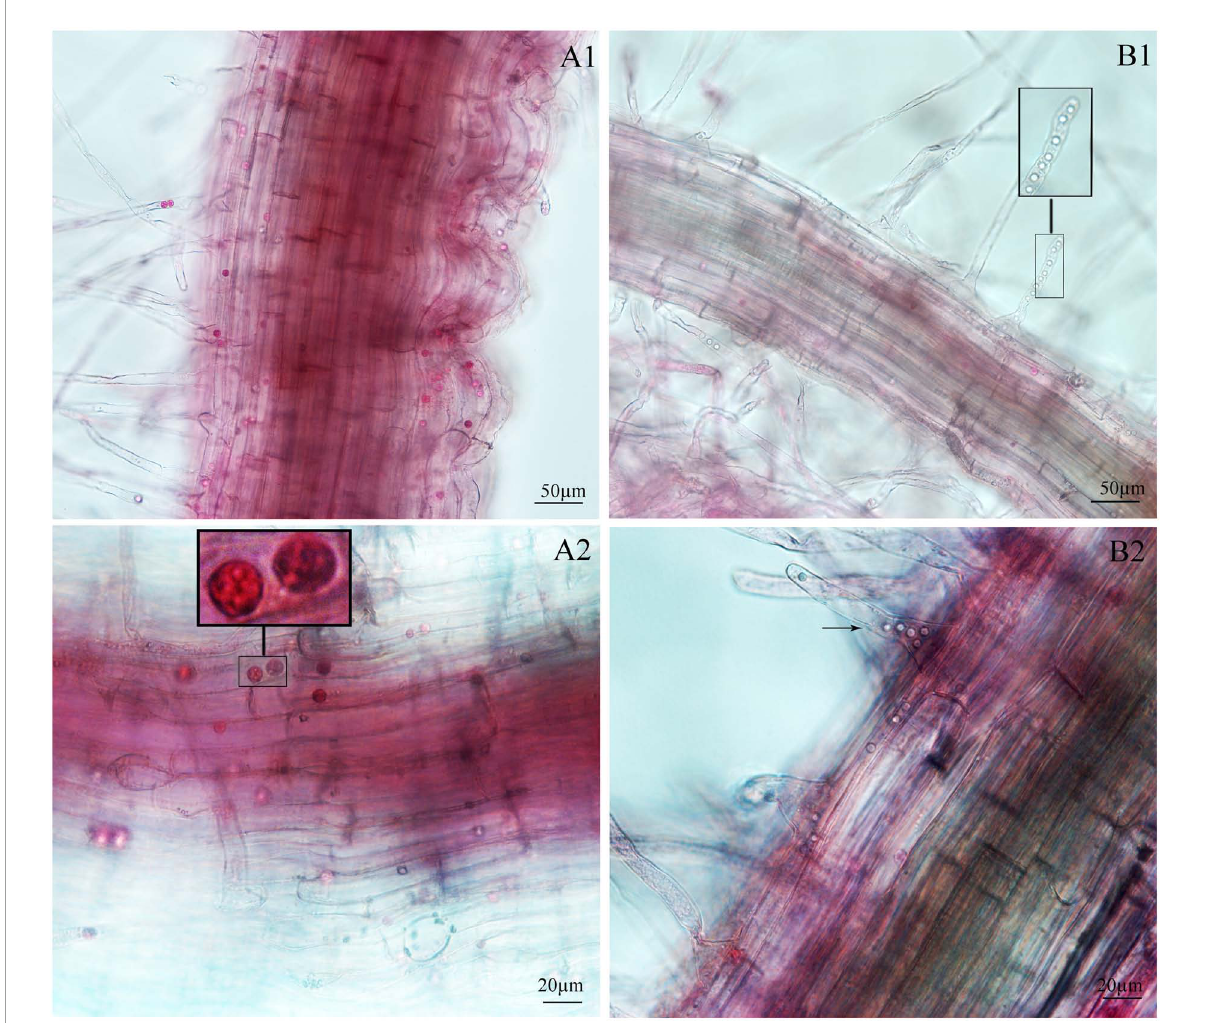
FIGURE4 Infection of spinach inoculated with secondary zoospores. (A1,A2) Images of secondary zoospore inoculation after 7 days. (B1,B2) Images of secondary zoospore inoculation after 12 days.